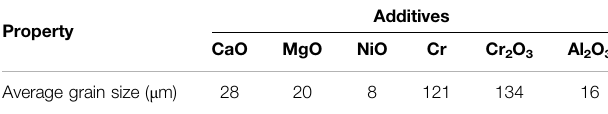
TABLE 3 | The average grain size of UO 2 pellets sintered with different additives.